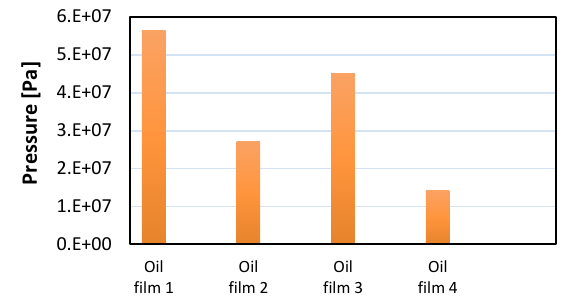
Fig. 11. Maximum pressure exerted by all the oil